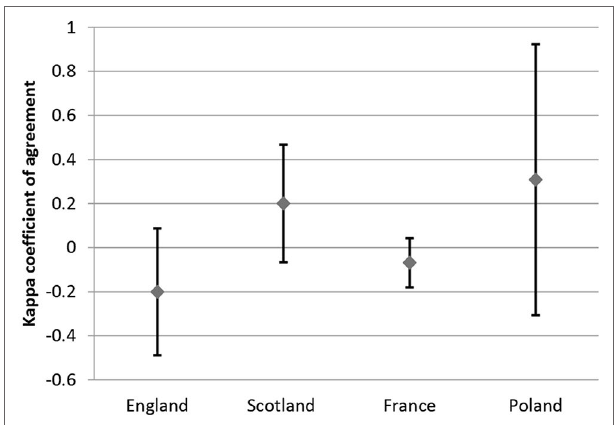
FIGURE 5 | Agreement Between Recommendations and Reimbursement Status—metabolic drugs.